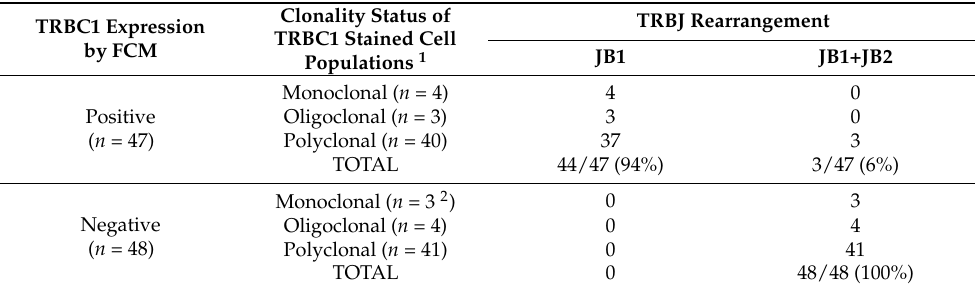
Table 2. TRBJ gene rearrangements of FACS-sorted TRBC1 positive and/or TRBC1 negative T αβ + cell populations ( n =